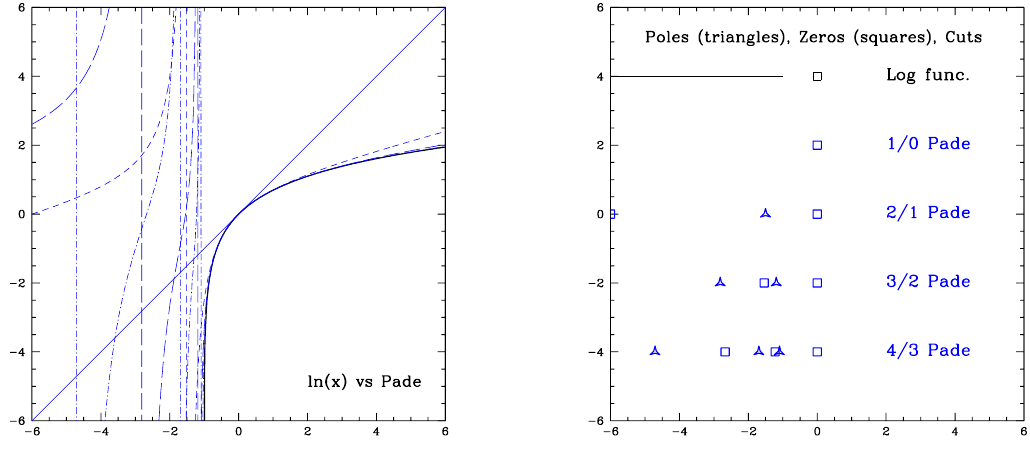
Figure 1 . Fitting the logarithm function ln(1 + x ) with Pad(cid:19)e. Left: comparing the log function to the (1,0), (2,1), (3,2), and (4,3) Pad(cid:19)e approximants. The higher approximants do an excellent job above x = (cid:0) 1 and have a series of poles and zeros where the logarithm has its cut. Right: